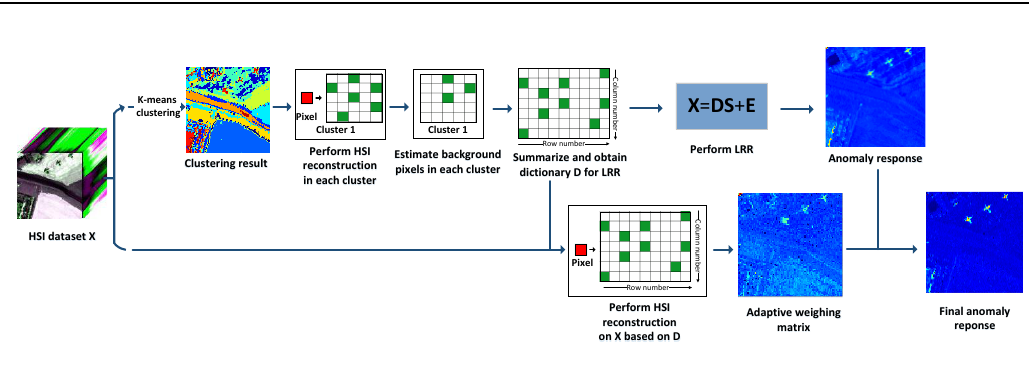
Figure 3. Schematic flowchart of the proposed DCLaAW algorithm for hyperspectral anomaly